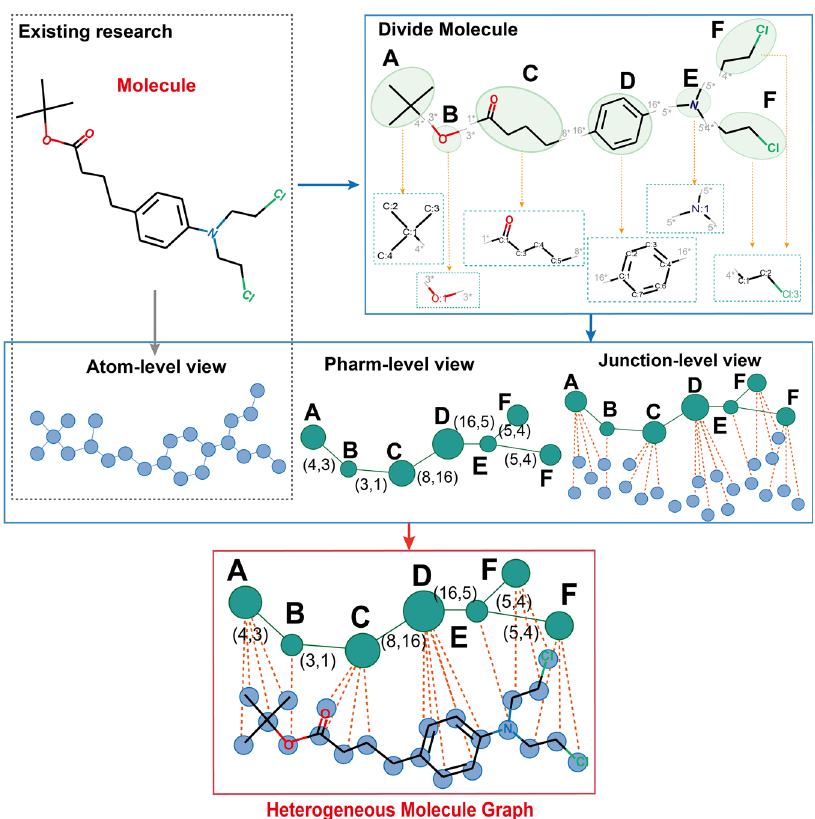
Fig. 1 An example of the overview of the molecular segmentation process and the construction of the heterogeneous molecular graph. In the heterogeneous molecular graph at the bottom, the green nodes represent fragments with pharmacophore information, and the blue nodes represent the atoms of the molecule. The green edges are the reaction information between fragments, the red dotted line edges are the related information of the atoms that connect the fragments, and the edges between atoms are